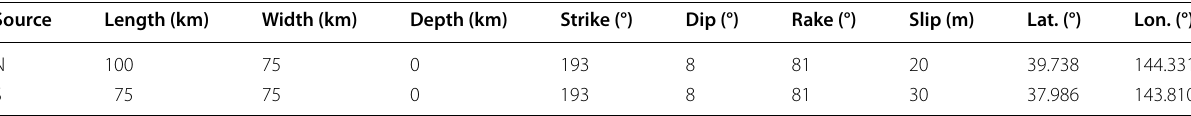
The definition of each parameter is the same as that by Satake et al. (2013)